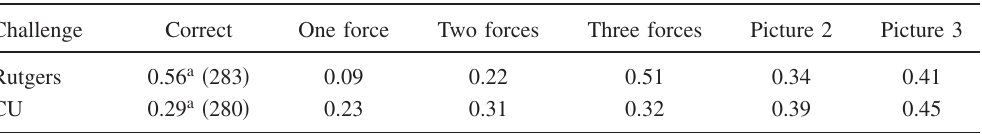
TABLE III. Fraction of students answering the challenge problem correctly, fraction correctly identifying one two, or three of the possible forces, and fraction drawing either picture type 2 or type 3. Parentheses indicate sample